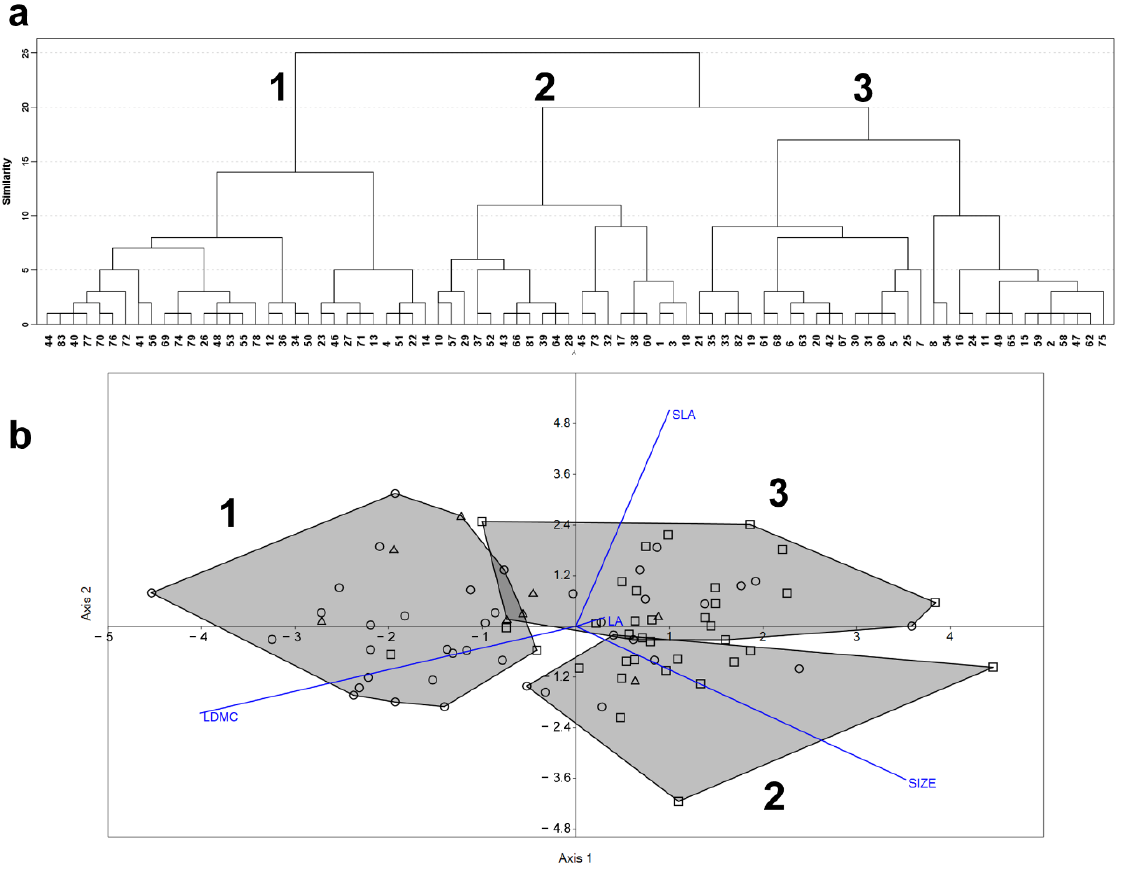
Figure 1. Functional groups obtained by the numerical classification of 82 plant species based on four functional traits ( a ) and discriminant analysis performed to test the reliability of the functional groups ( b ). Biplot symbols: circles, species exclusive to the xerophile community; squares, species exclusive to the mesophile community; triangles, species found in both communities. Table 1. Confusion matrix showing the attributions produced by the discriminant analysis (columns) with respect to the functional groups (FGs) obtained by the cluster analysis (rows) performed on the four functional traits. CC(%) = percent of correct classifications.